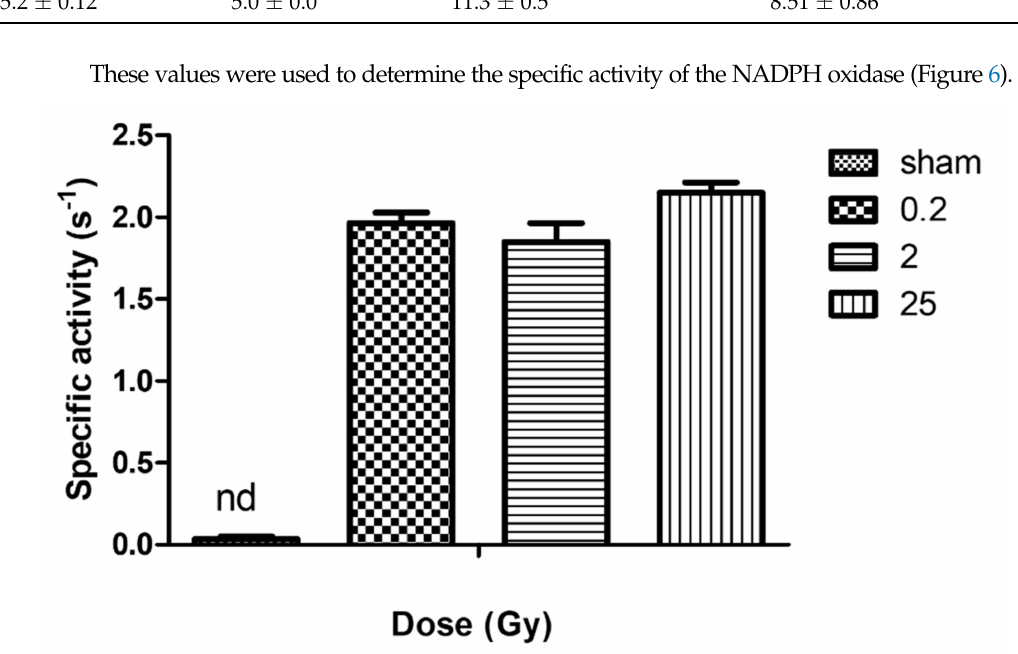
Figure 6. Specific activity of NADPH oxidase from irradiated and non-irradiated PLB-985 cells. Superoxide production was determined in vitro using membrane fractions purified from irradiated (4 nM cyt b 558 ) surviving PLB-985 cells mixed with purified cytosolic fractions from each preparation (250 µ g each) and incubated in activity buffer (PBS solution supplemented with 10 mM MgSO 4 ) for 5 min in the presence of AA (40 µ M). NADPH (200 µ M) was added to initiate the reaction and 50 µ M of cyt c to measure superoxide rate of production. The activity was calculated from the initial rate of reaction at 550 nm using an extinction coefficient of 21 M − 1 cm − 1 . Specific activity indicates the amount of superoxide produced per second per mole of cyt b 558 of NADPH oxidase. Data are the mean ± SEM of 3 independent experiments. nd represents non-determined for the non-irradiated